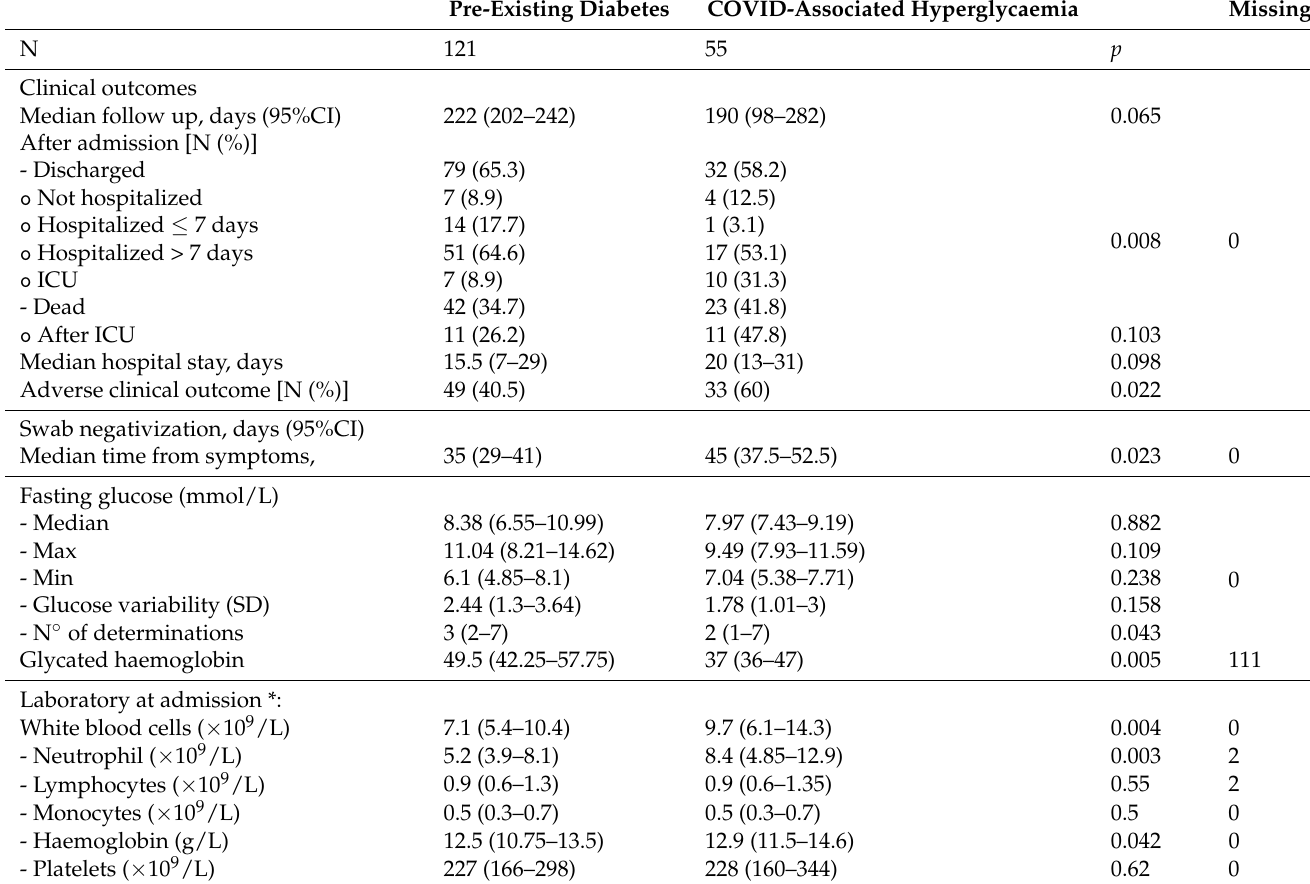
Table 1. Clinical laboratory profile at hospital admission and clinical outcome. Pre-Existing